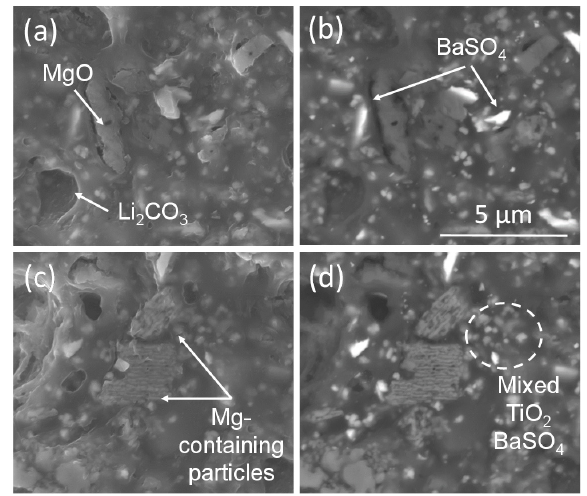
Figure 3. Examples of inorganic particles that make up the sample configurations for measuring Li depletion. Examples of ( a ) MgO and Li 2 CO 3 partticles, ( b ) BaSO 4 particles, ( c ) Mg ‐ containing particles and ( d ) mixed TiO 2 and BaSO 4 particles. The dark areas spots show where point analyses have been performed.